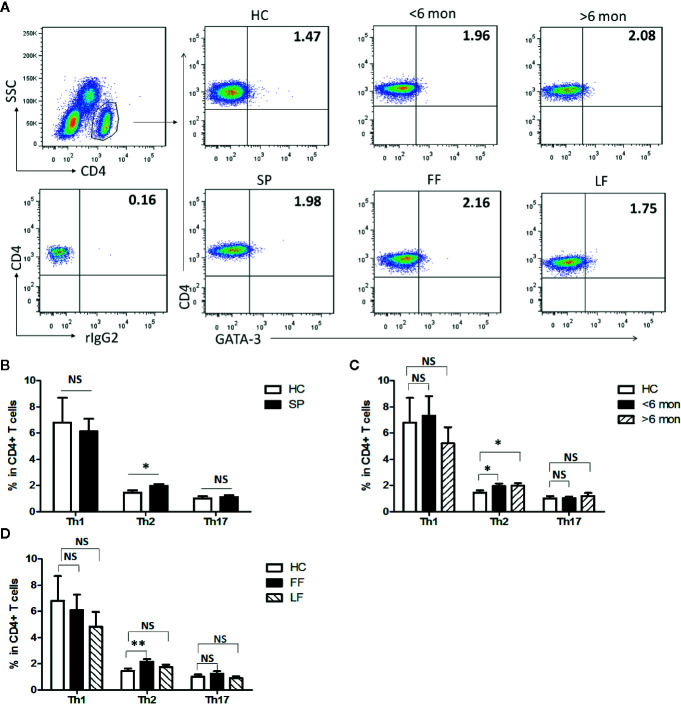
Altered distribution of Th1, Th2, and Th17 in PBMCs of patients. (A) PBMCs were stained intracellularly with T-bet, GATA-3, and ROR-γt mAbs after surface staining of CD4 mAb. According to CD4 staining and SSC, CD4+ T cells were gated. The parameters shown in quadrants of the representative graphs are mean frequency of GATA-3 for each group. (B–D) The average percentages of CD4+T-bet+ Th1, CD4+GATA-3+ Th2, CD4+ROR-γt+ Th17 are compared between HC (n = 24) and whole patients (n = 50) as well as subgroups of patients (SD, n = 24; LD, n = 26; FF, n = 33; LF, n = 17). Error bars represent mean±SD. **P < 0.01, *P < 0.05, and NS P ≥ 0.05.